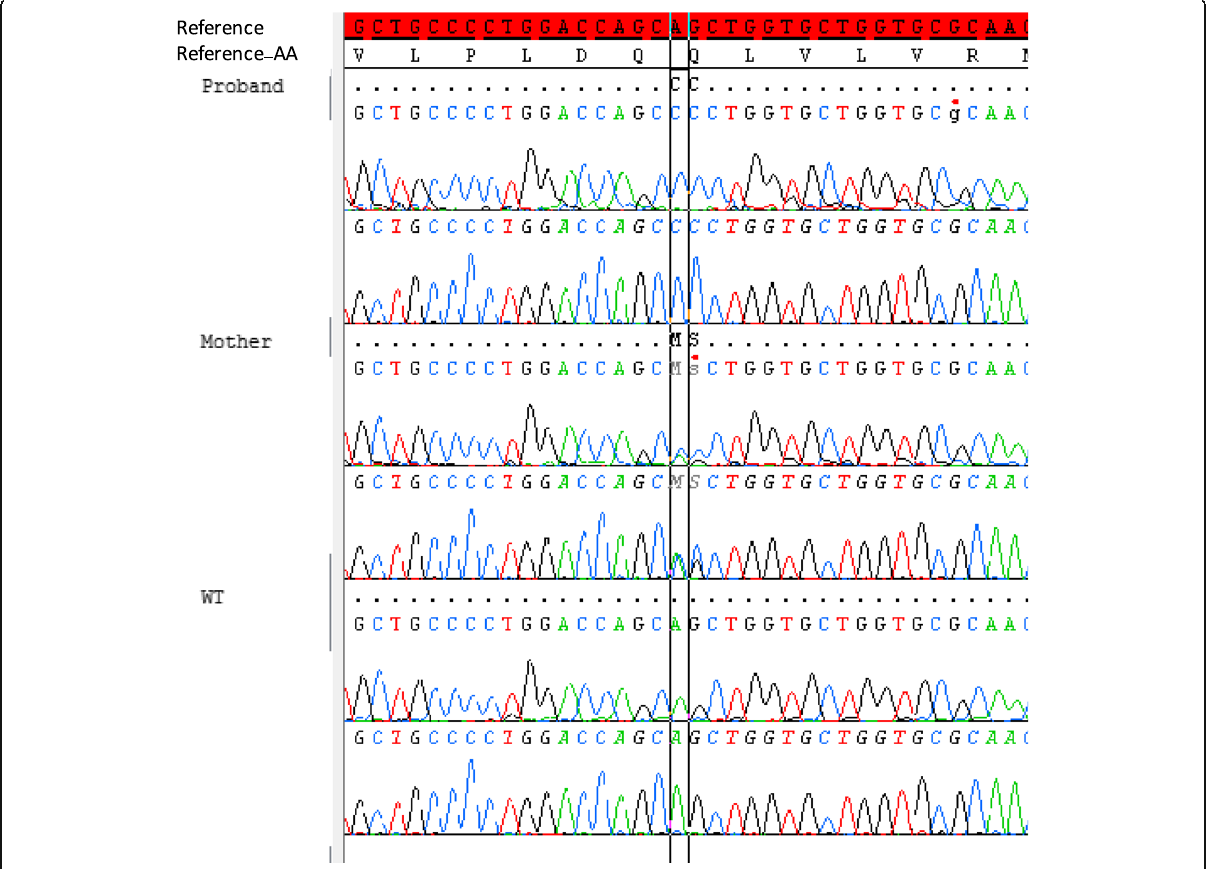
Fig. 1 Partial chromatograms showing the novel NR0B1 /DAX-1 mutation. Base change c.848_849delinsCC leading to the missense mutation p.(Gln283Pro). The reference sequence is in highlighted in red. The proband ’ s DNA sequence is above, the mother ’ s DNA sequence in the middle and a healthy control ’ s sequence